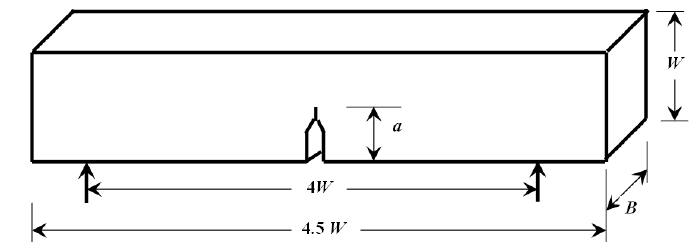
Figure 1: The geometry of the SENB specimen used in the analysis ( W =20 mm).